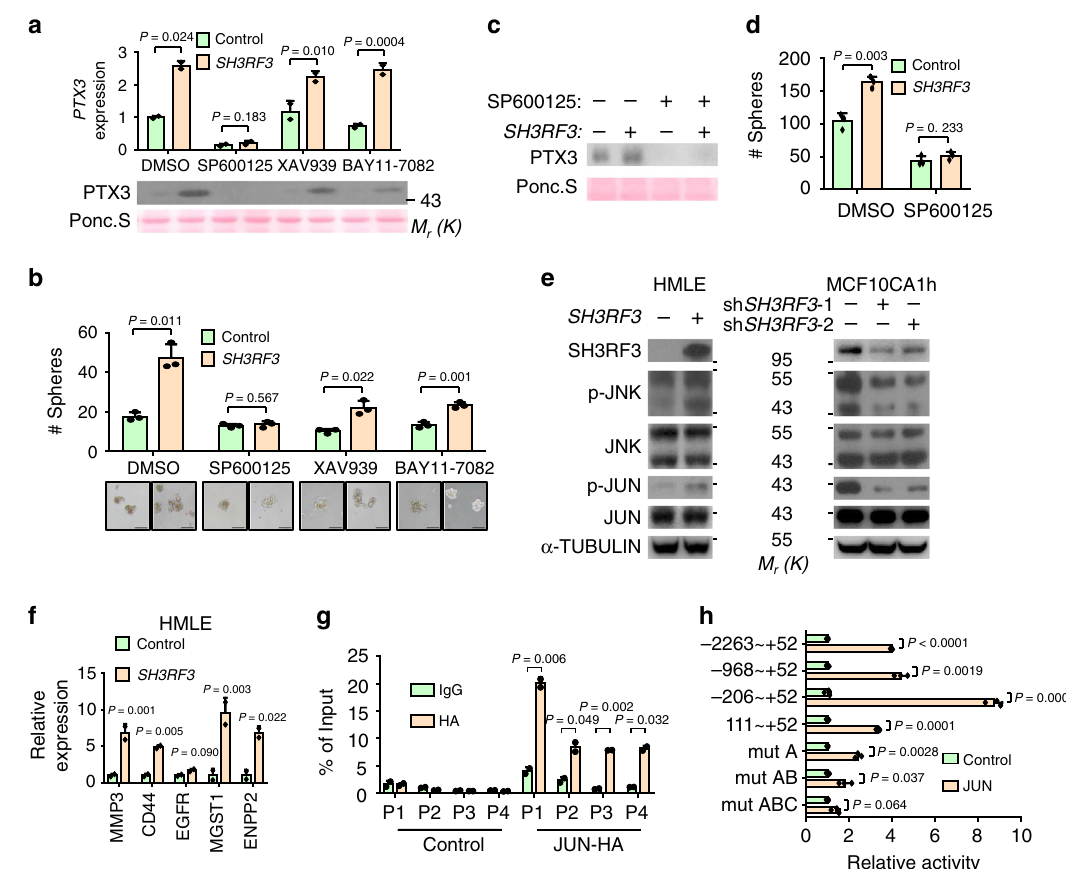
Fig. 6 SH3RF3 enhances PTX3 expression through JNK-JUN pathway. a , b PTX3 expression ( a ) and tumorsphere formation ( b , n = 3 culturing experiments) of SH3RF3 -overexpressing and control HMLE cells treated with inhibitors of JNK (SP600125, 5 nM), WNT (XAV939, 5 nM), and NF- κ B (BAY11-7082, 5 nM). c , d PTX3 expression ( c ) and tumorsphere formation ( d , n = 3 culturing experiments) of SH3RF3 -overexpressing and control MDA- MB-231 cells treated with the JNK inhibitor. e JNK and JUN phosphorylation after SH3RF3 overexpression and knockdown. f Expression of JUN-target genes after SH3RF3 overexpression in HMLE ( n = 3 qRT-PCR experiments). g ChIP-qPCR analysis of JUN binding to PTX3 promoter in HeLa ( n = 3 ChIP experiments). h Luciferase reporter analysis of PTX3 promoter in JUN -overexpressing and control HeLa cells ( n = 3 reporter assays). Data represent